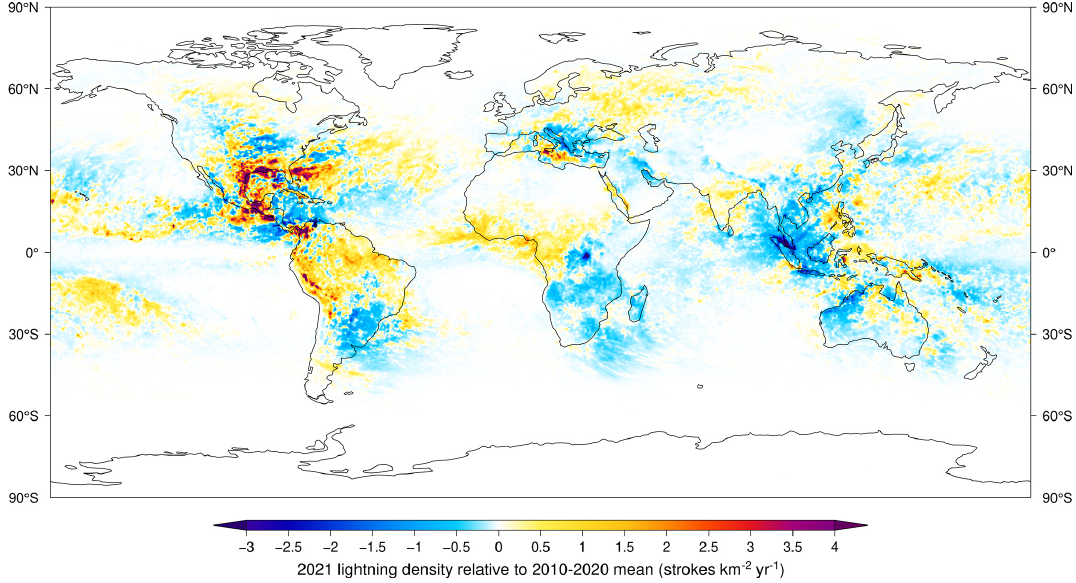
Figure 3. Difference between lightning observed in 2021 and the 2010–2020 climatological